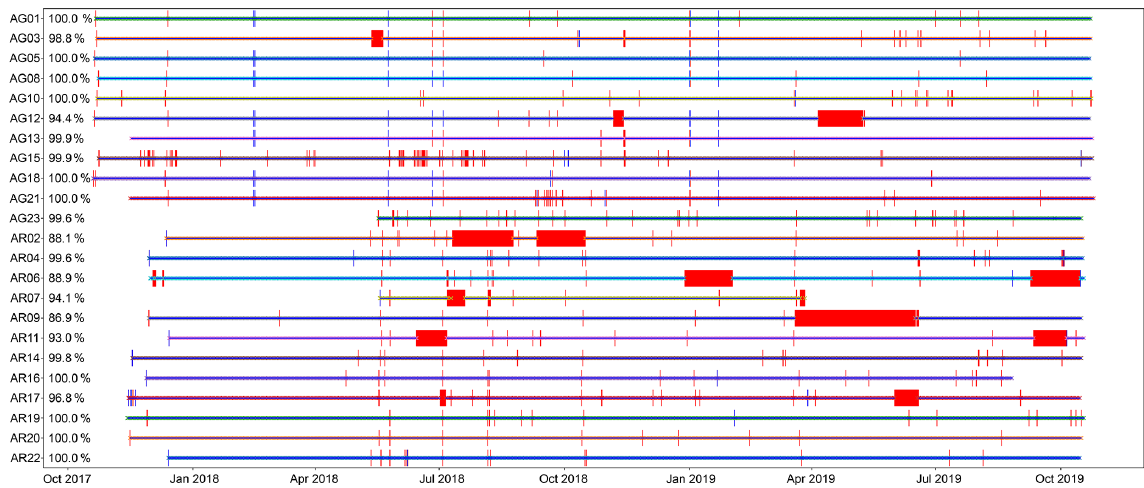
Figure 5. The diagram showing the data completeness for temporary stations. Red fragments – gaps in the data resulting from stations failures, memory card errors and power shortages.